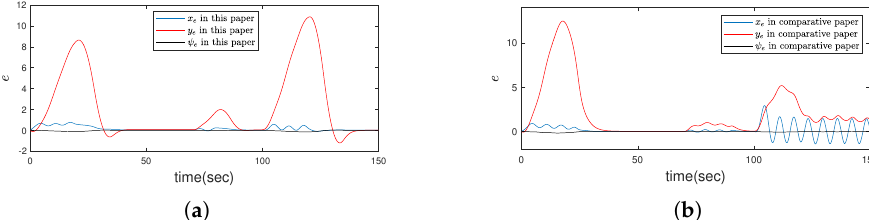
Figure 4. ( a ) The response curves for position errors in this paper. ( b ) The contrastive curves for position errors in method that ignores the effect of thruster saturation respectively in [15].